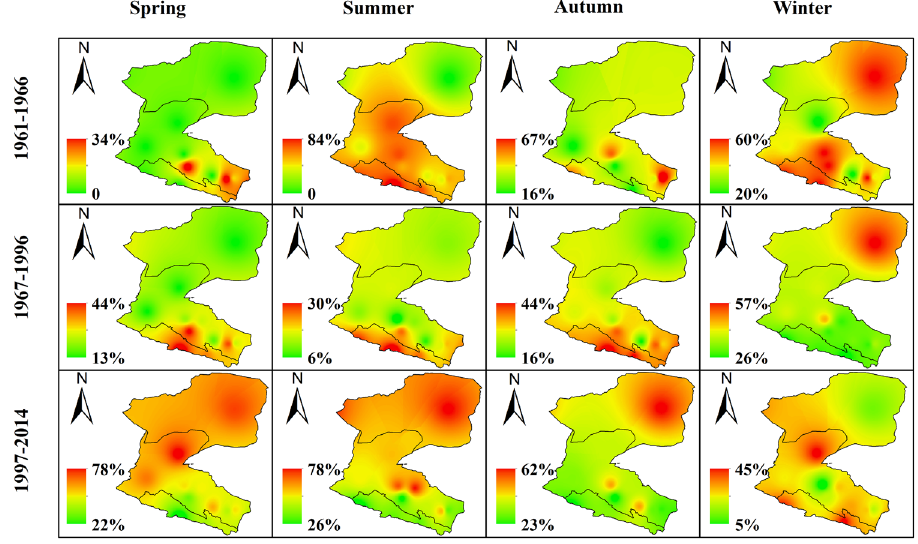
Fig. 8 Spatial distribution characteristics of the seasonal drought frequency in the Heihe River Basin in the three subperiods during 1961–2014